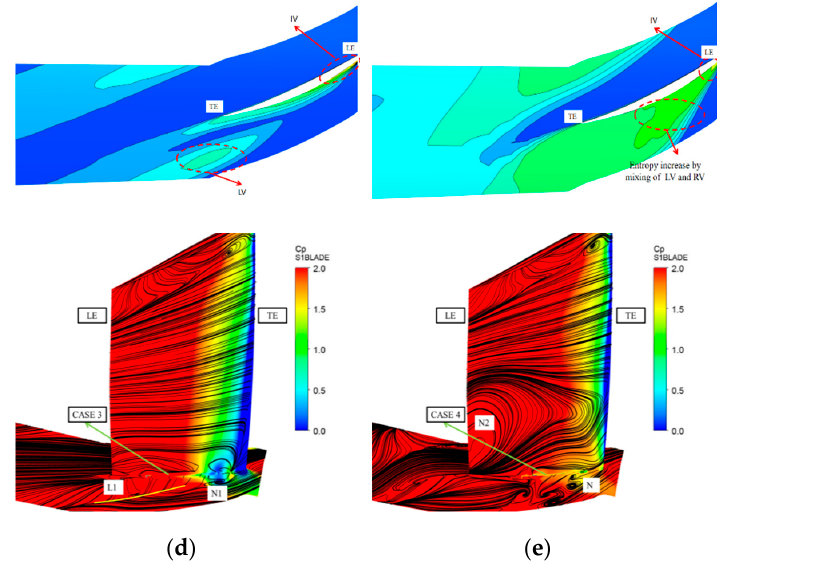
Figure 9. Static pressure contour / limiting streamlines and entropy contour at 0.05 H for ( a ) Ori, ( b ) Case 1, ( c ) Case 2, ( d ) Case 3, and ( e ) Case 4.